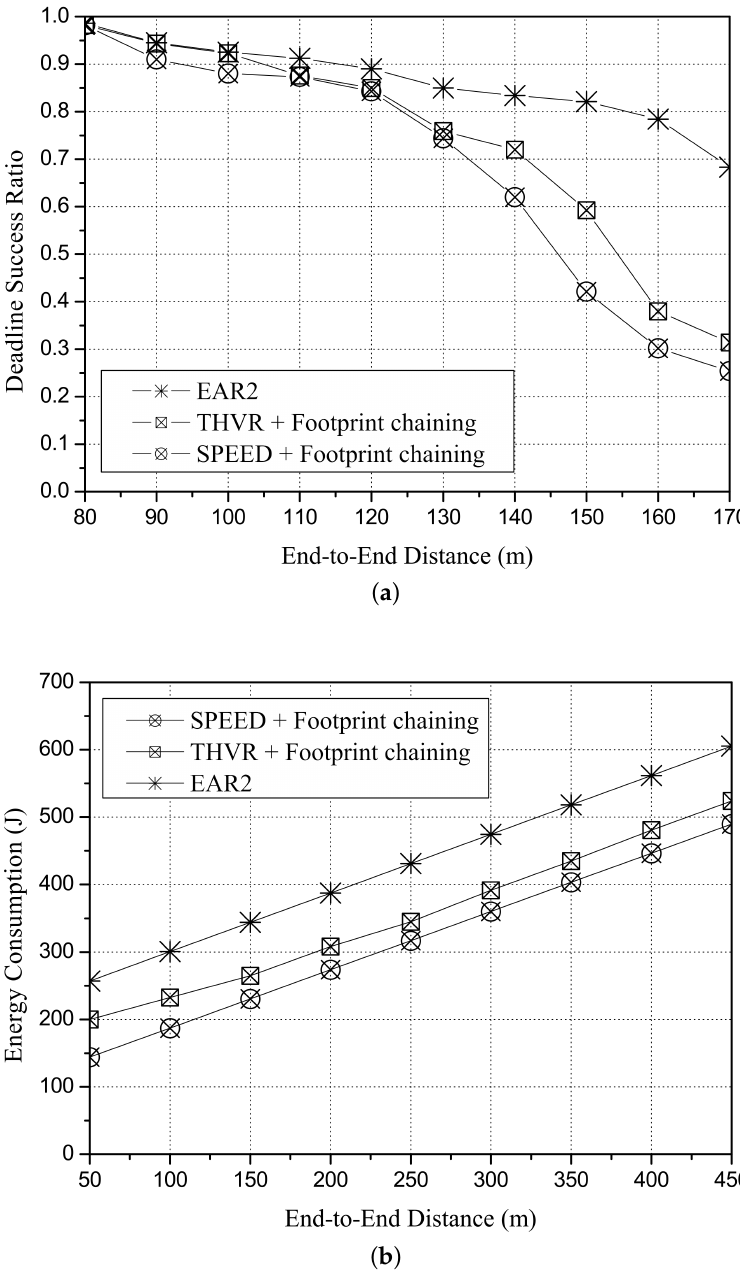
Figure 6. Performance comparison of EAR2 with the existing schemes SPEED and THVR according to end-to-end distance: ( a ) deadline success ratio and ( b ) energy